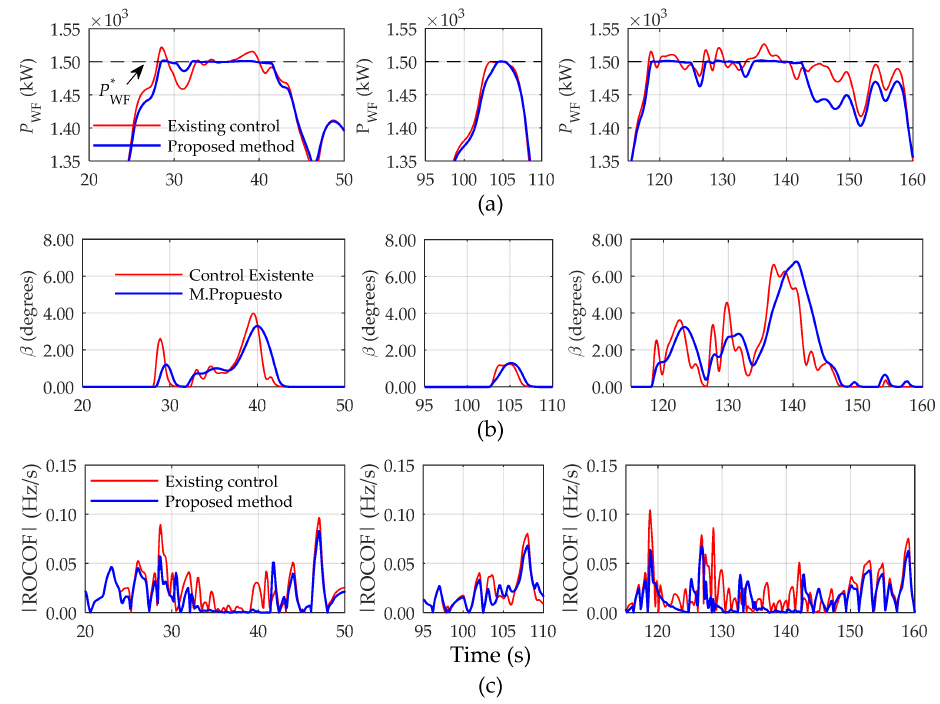
Figure 18. Time-domain simulation results by implementing the wind curtailment proposal: ( a ) Wind farm output power; ( b ) Blade pitch angle and; ( c )